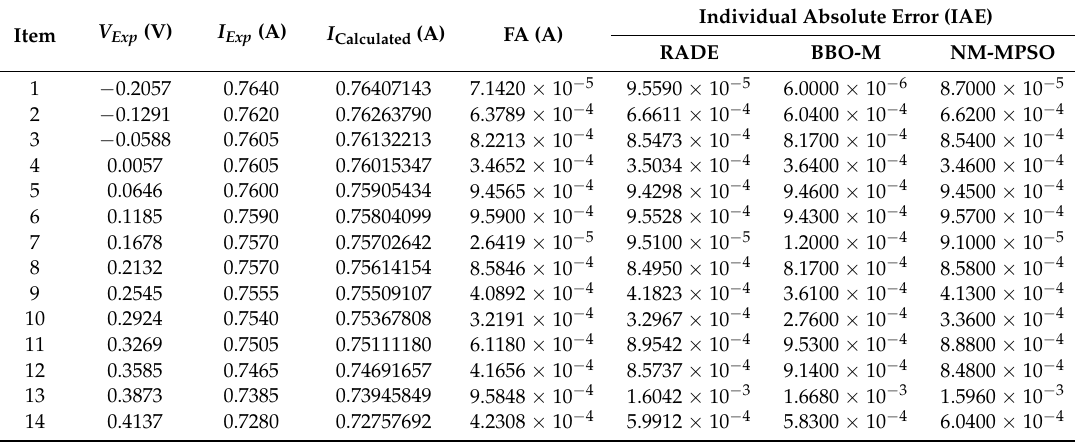
Table 5. Calculated current and compared IAE for single diode (RTC France